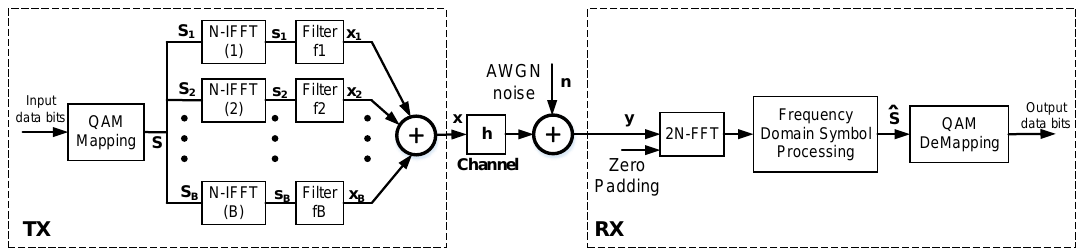
Figure 1. The typical block diagram of the universal filtered multi-carrier (UFMC)